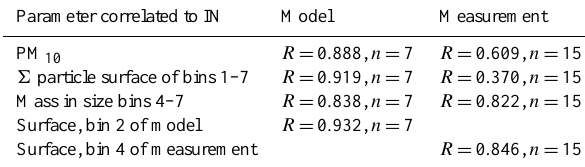
Table 2. Linear Correlation coefficients between ice nuclei num- ber concentration (#/l) and measured or modelled (spectral) aerosol properties. The PM model data for the correlation analysis were lin- 10 early interpolated for the time of aerosol sampling (usually 2/day) within the 3h time step in the model output. The IN data used for correlation analysis were (a) the means of daily pairs of samples (triangles in the insets of Fig. 8, n = 7) for correlation to model data, and (b) all individual data points of the period May 24 through June 1 (diamonds, n = 15) for correlation to measurement data. Parameter correlated to